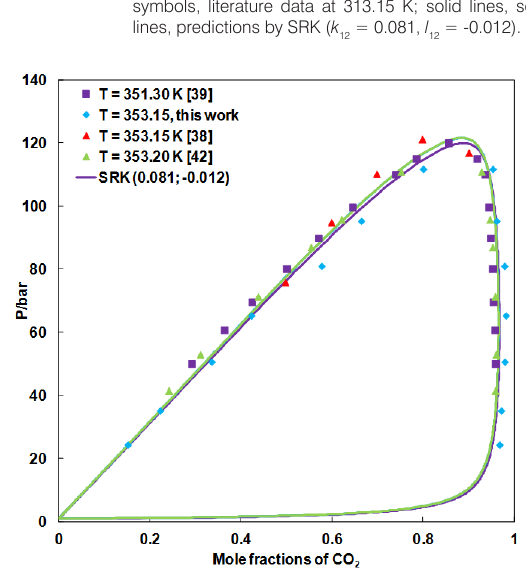
Figure 4. Comparison of new measured and literature data for the carbon dioxide + 2-methyl-2-propanol ( tert -butanol) system and calculations by SRK model: symbols, this work and literature data at ~353.15 K; solid lines, predictions by SRK ( k = 0.081, l = -0.012). 12 12